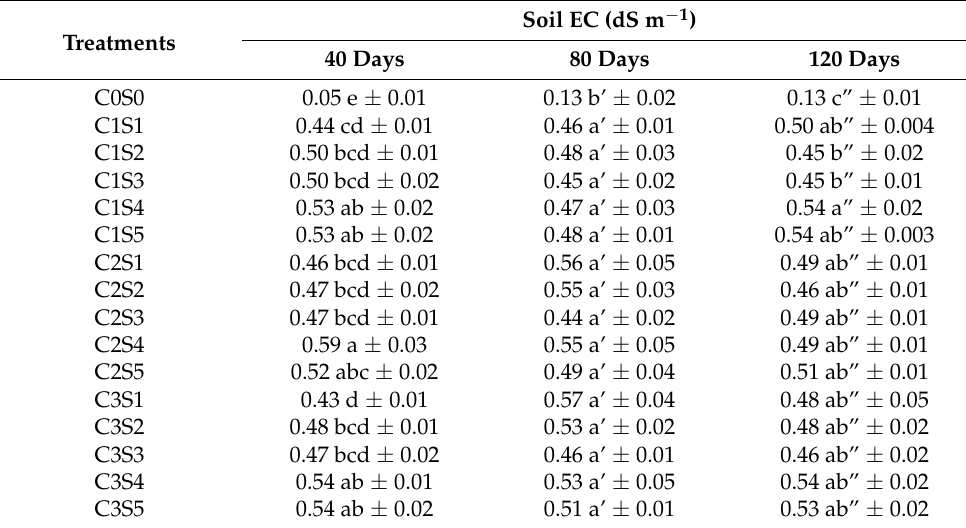
Table 11. Mean soil electrical conductivity in relation to combined use of Calciprill and sodium silicate at forty, eighty, and one hundred and twenty days incubation.